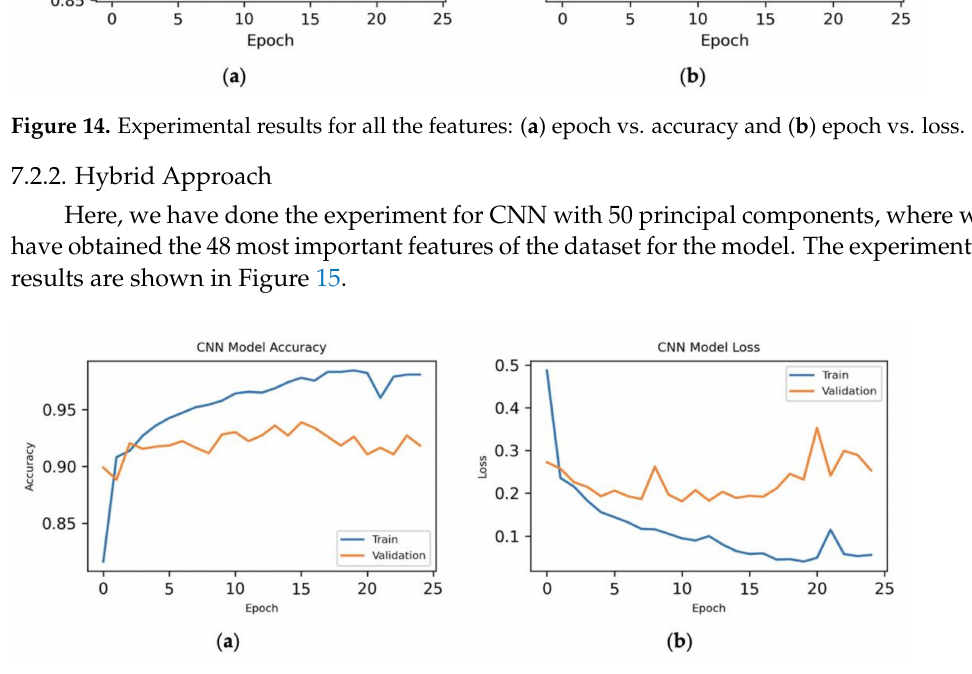
Figure 15. Experimental results for 48 features: ( a ) epoch vs. accuracy and ( b ) epoch vs. loss.